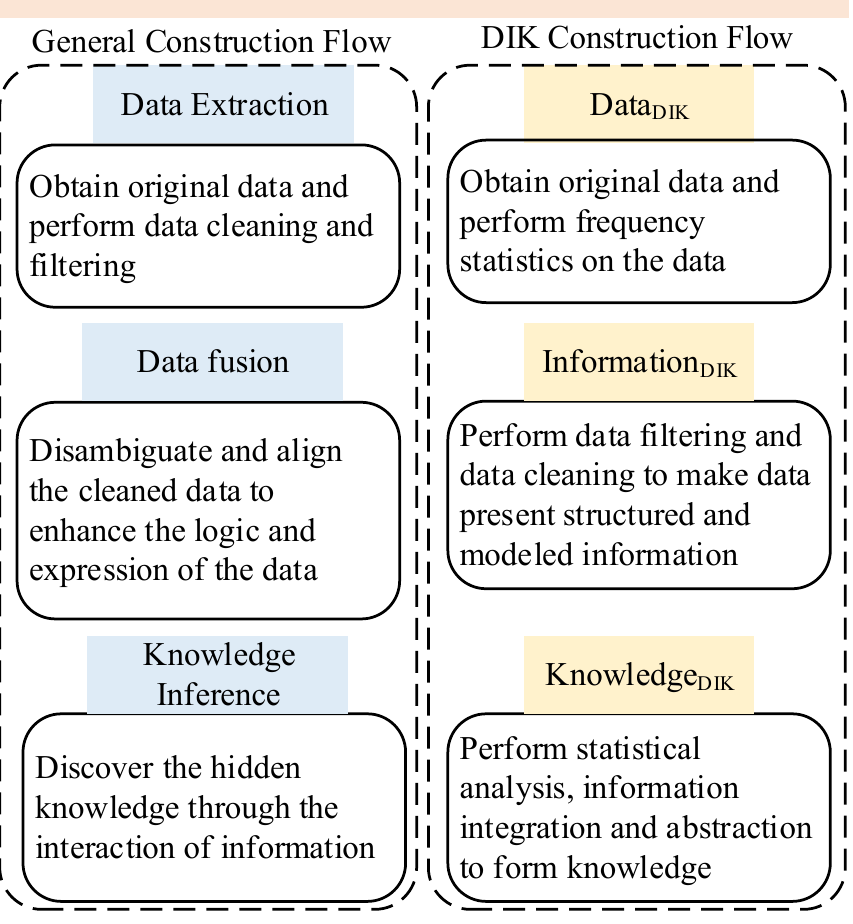
Figure 5. Comparison of two knowledge graph construction processes.